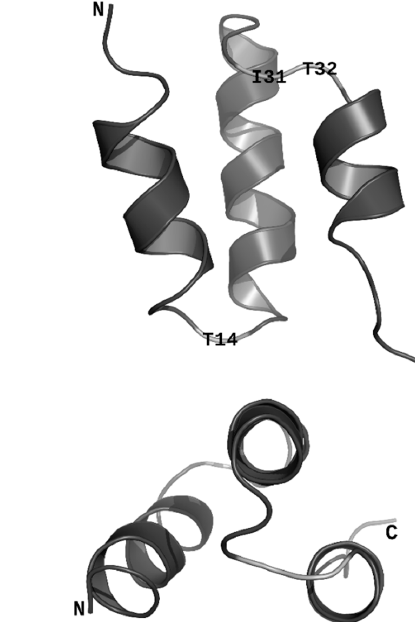
Figure 2. ORF47 overall fold in ribbon representation. The free amino group (N-terminus) is indicated as N. The carboxyl group (C-terminus) is indicated as C. ( A ) ORF47 representation showing the three α -helices. The three highlighted residues are the three least conserved residues among ORF47 homologues and are all located in loops. ( B ) ORF47 representation showing that two of the three α -helices are parallel. PDB ID: